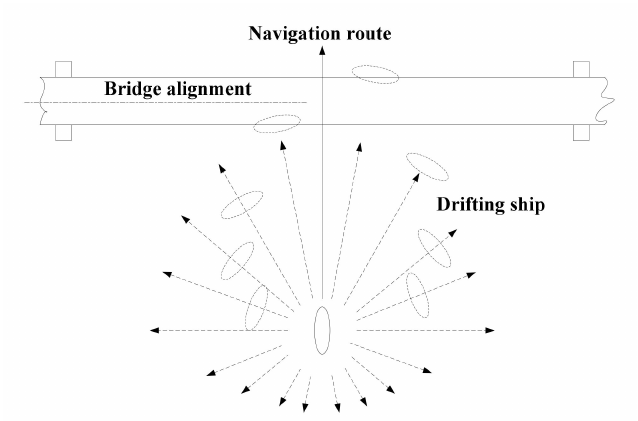
Figure 3. Ship drifts towards the bridge line (based on [28]).